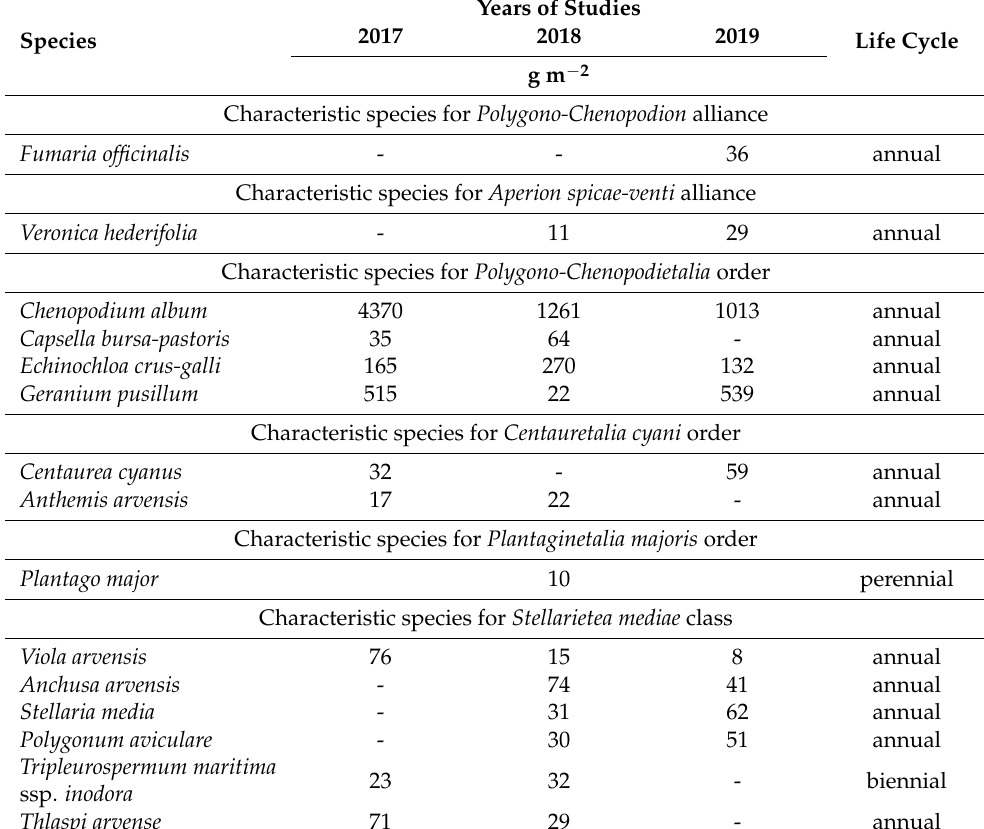
Table 1. Phytosociological classification and abundance of species in the community.